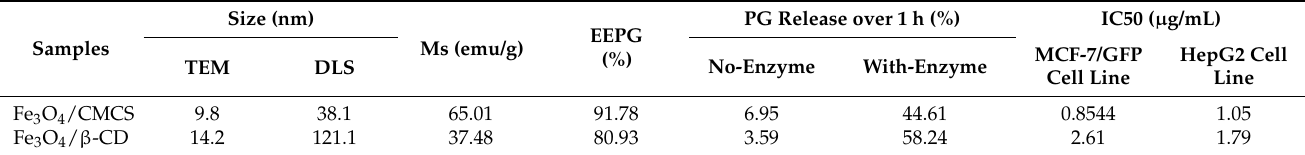
Figure 3. Enzyme-responsive, glycine-coated, MTX-conjugated Fe 3 O 4 NPs. Redrawn from [209]. Table 4. The morphology, magnetic, loading, and release properties and IC50 values of Fe 3 O 4 /CM-CS and Fe 3 O 4 / β